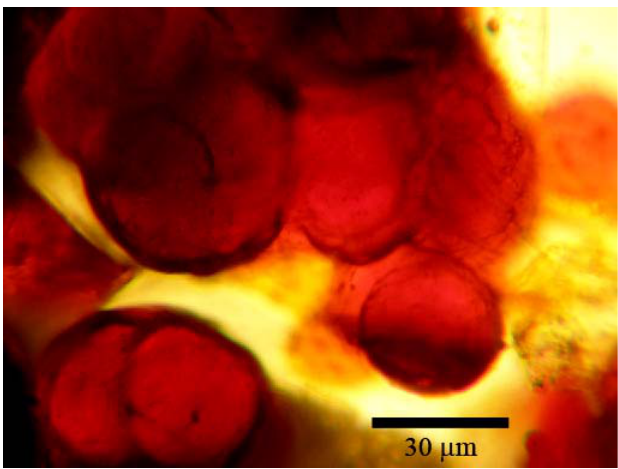
Figure 6. Sphalerite spherulites on the walls of an open fracture at Ersmarksberget.